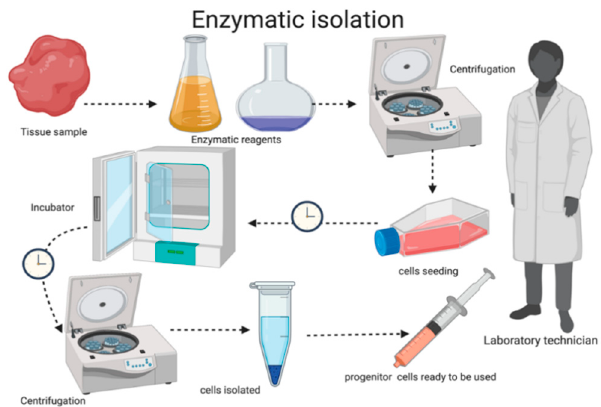
Figure 3. Workflow of the enzymatic process with several passages requiring a technician.